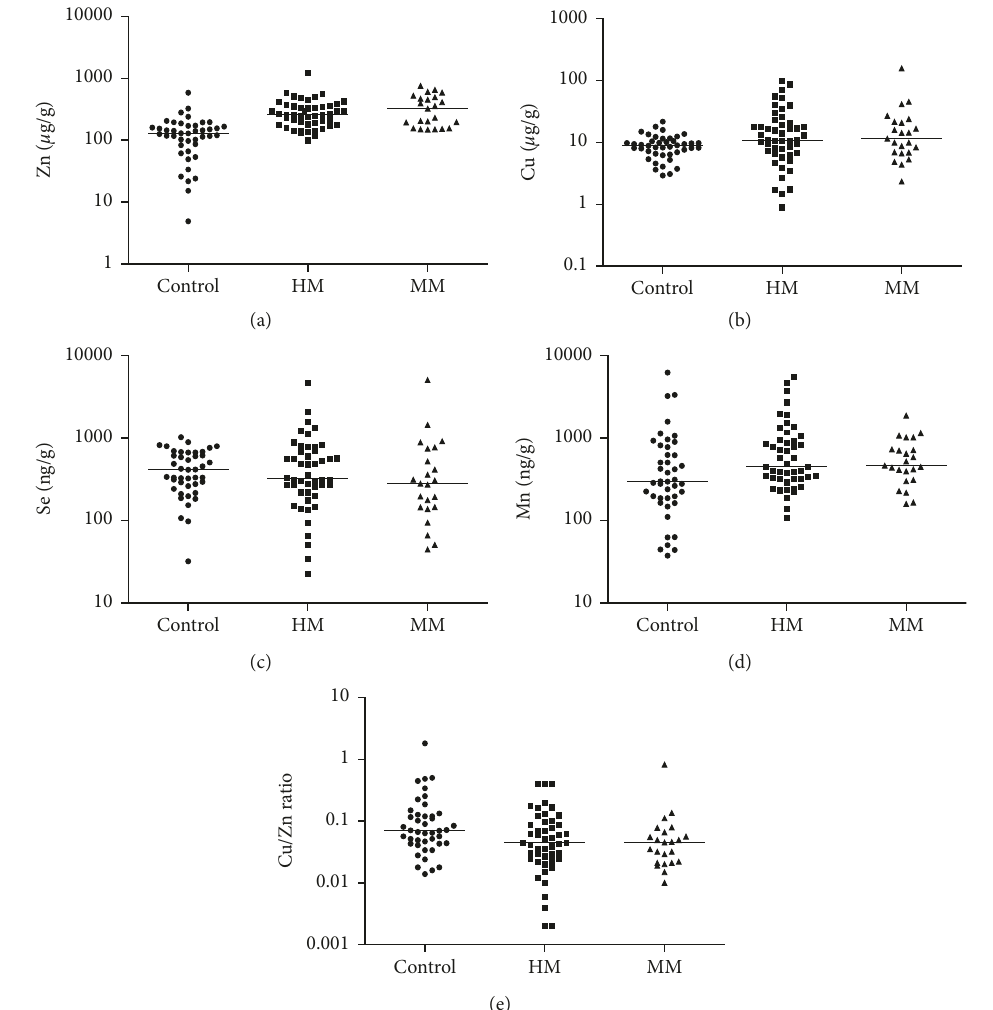
Figure 1: Hair trace elements (Zn, Cu, Se, and Mn) concentration and Cu/Zn ratio in the control group compared to patients with MM group and HM